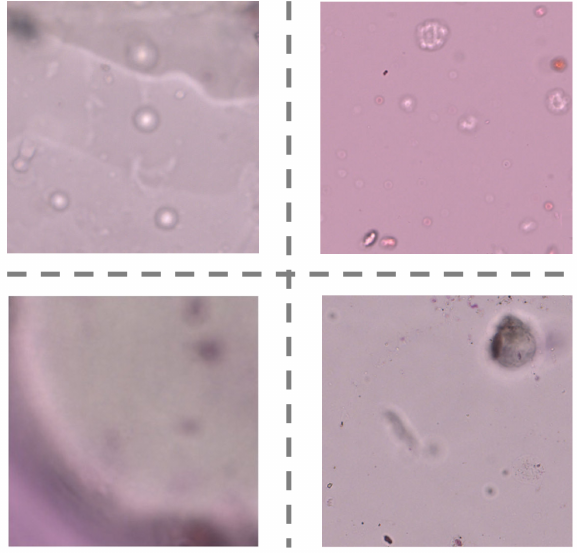
Figure 10. Some examples of misclassification from “Direct sampling+ Fined-grained classifica- tion” combination.